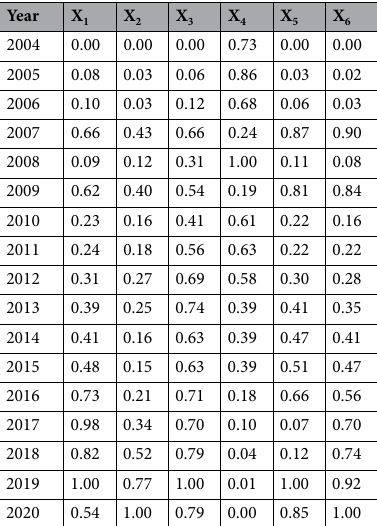
Table 5. Standardized data of indicators related to total factor productivity of Guangxi construction industry from 2004 to 2020.